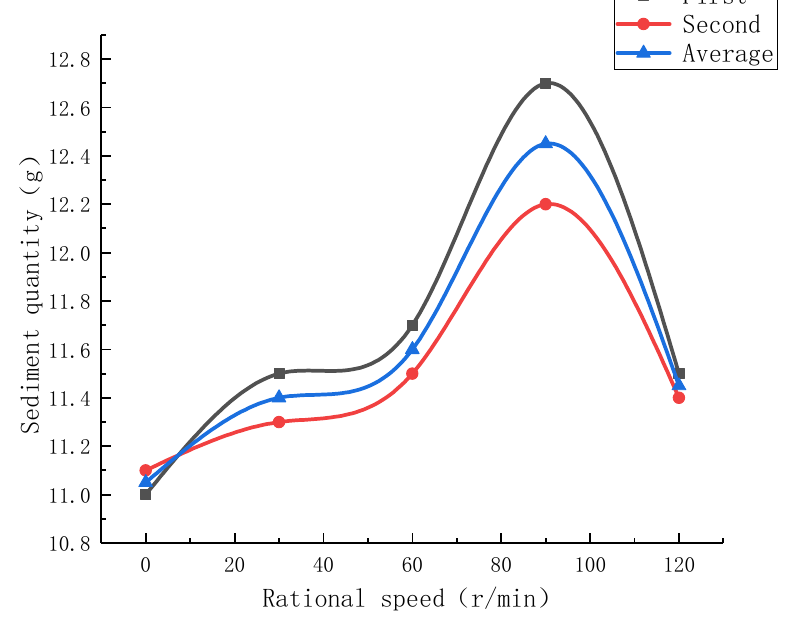
Figure 5. Sediment quality curves at different shear rates.